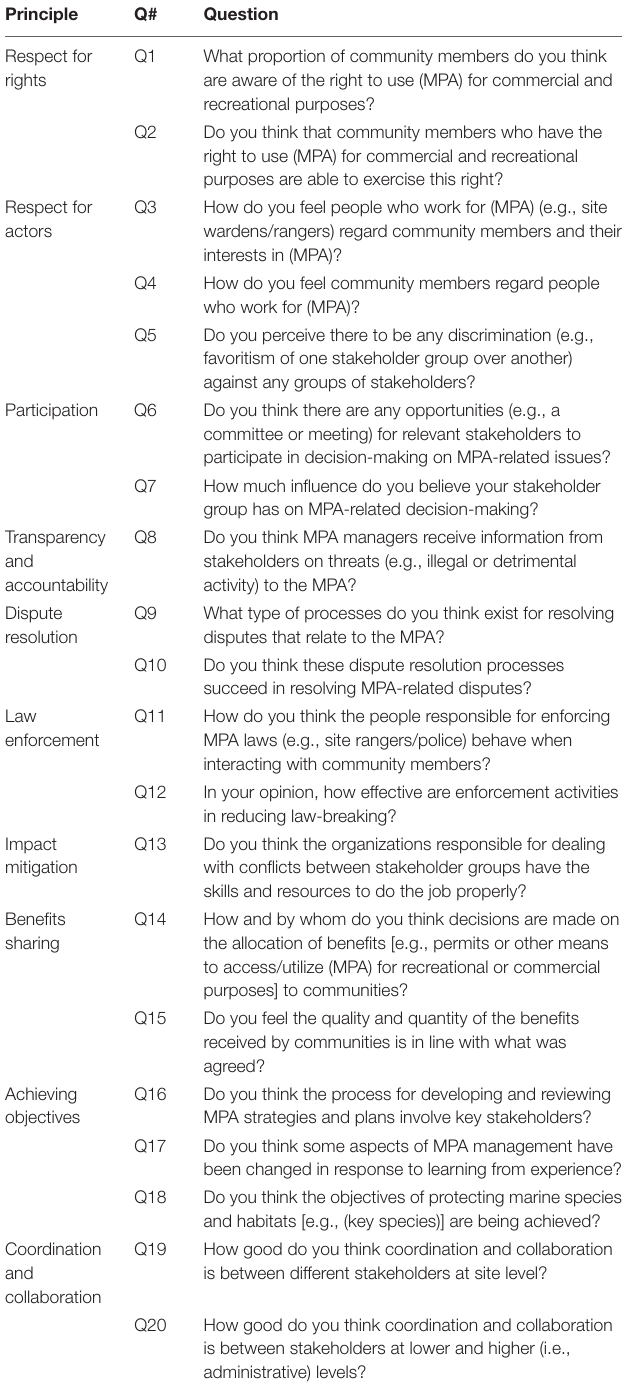
TABLE 1 | SAGE questions by equity and governance